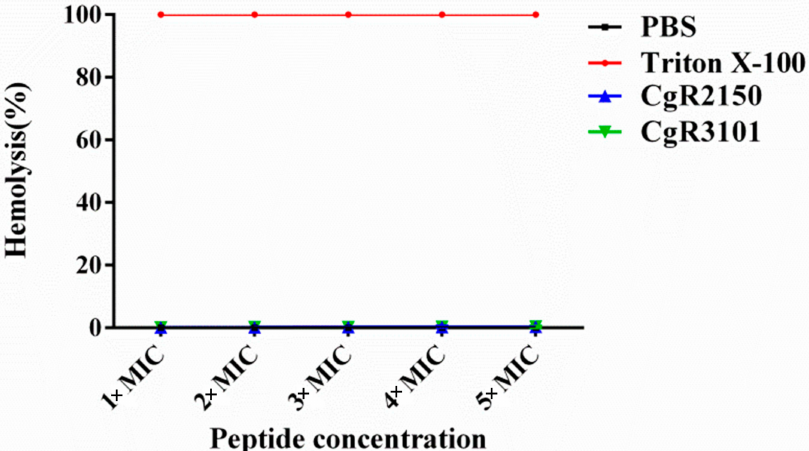
Figure 11. Hemolytic activities of the peptides on mammalian porcine erythrocytes.